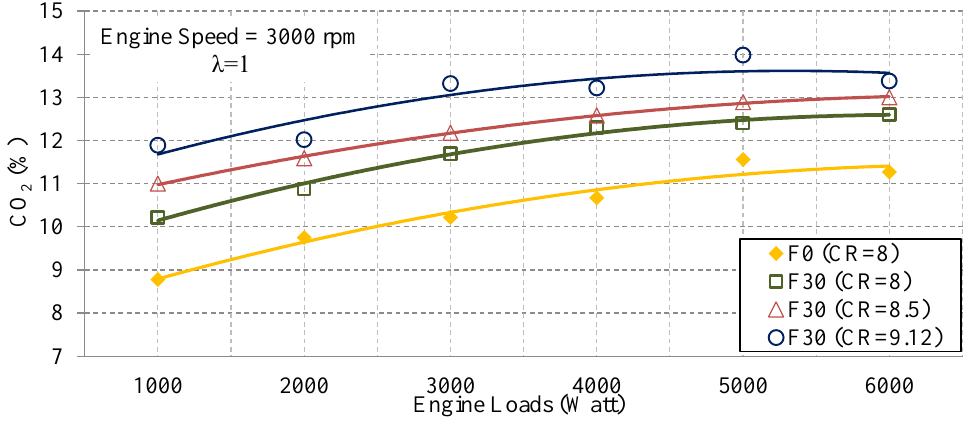
Figure 12. CO 2 graph for F0 and F30 at different compression ratios.